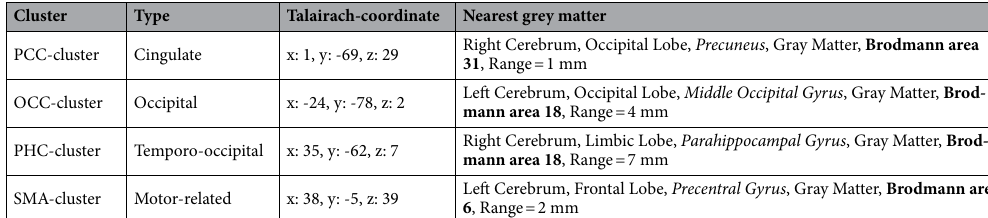
Table 1. The nearest grey matter of each cluster and their respective Talairach coordinates. The range indicates the distance in millimetres.